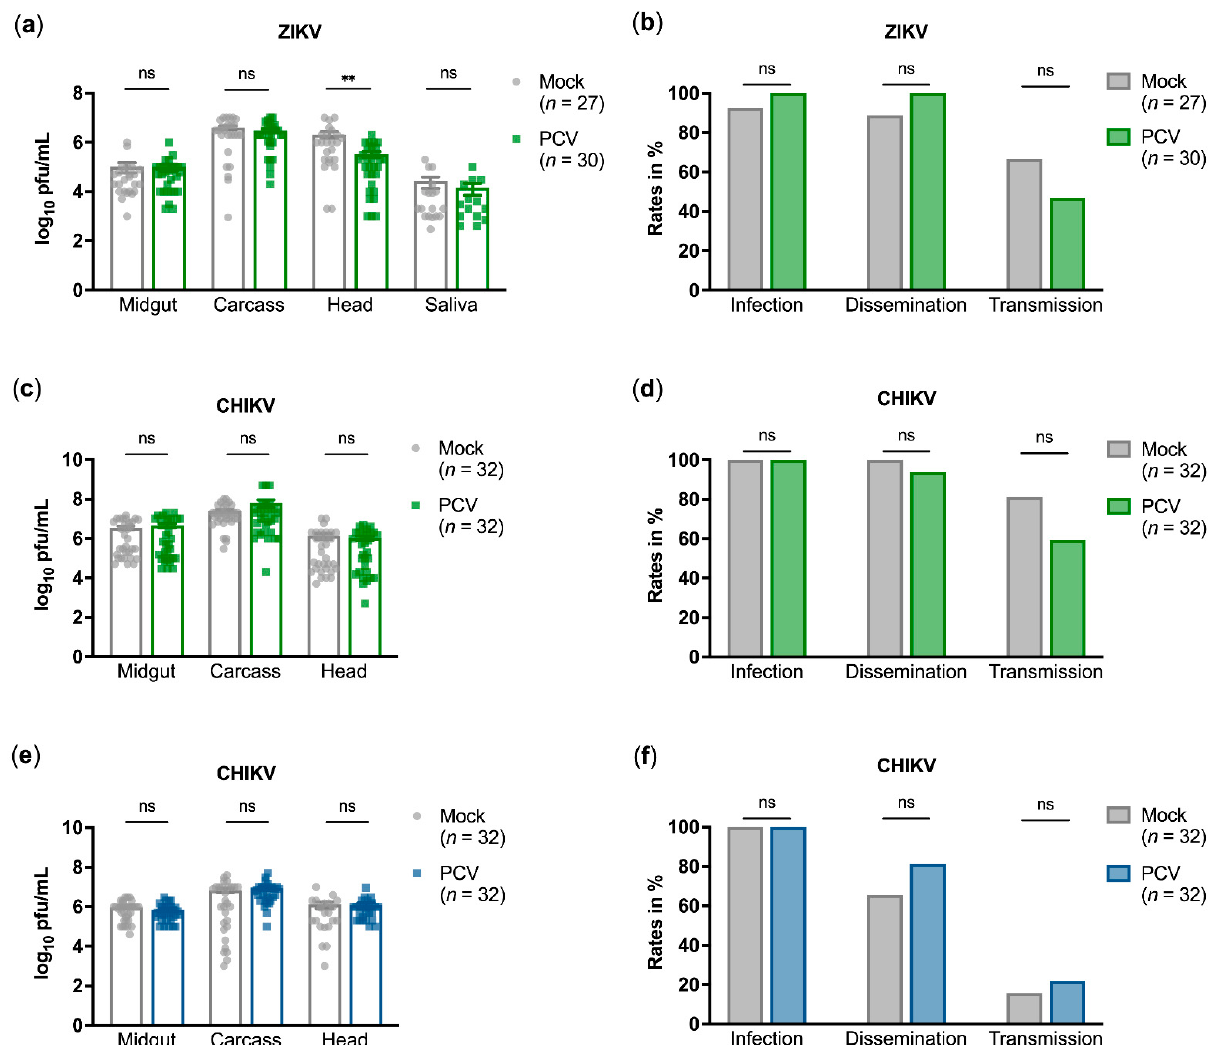
Figure 2. Palm Creek virus co-infection with Zika virus (ZIKV) or chikungunya virus (CHIKV) in Aedes aegypti ( a – d ) and Ae. albopictus ( e , f ) mosquitoes. ( a , c , e ) Arbovirus titres in tissues were titrated by plaque assay. Each data point denotes an individual tissue positive for arbovirus infection from two experimental replicates. Means and standard errors are shown. Mann–Whitney tests with Holm–Šidák multiple test correction were performed. ( b , d , f ) Infection, dissemination, and transmission rates as calculated by percentage of midgut, head, and saliva samples positive for infectious arbovirus, respectively. Fisher’s exact tests were performed. For all statistical tests, ns denotes no significant difference; ** denotes p -value < 0.01.